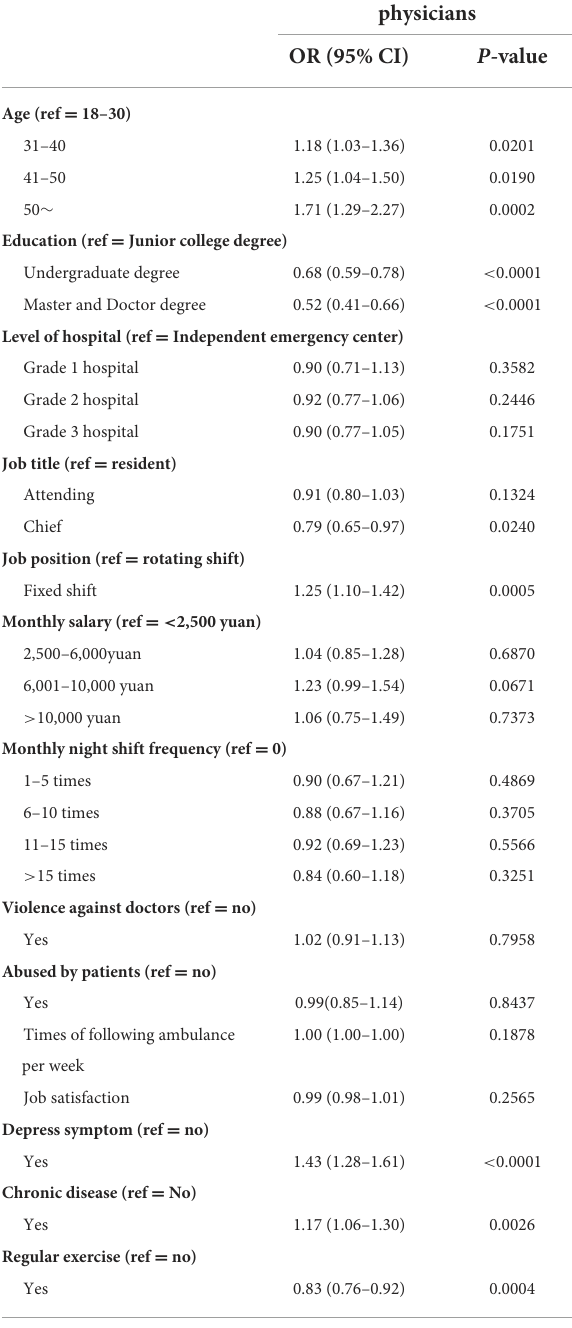
TABLE 2 Multivariate logistic regression for characteristics associated with smoking behavior of male physicians in emergency